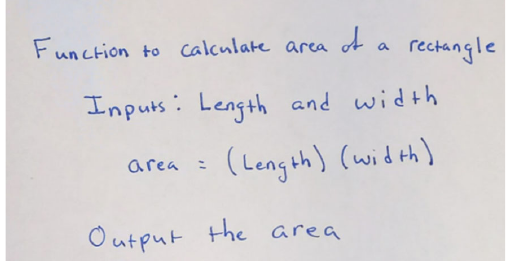
FIG. 3. An example of a pseudo-code for calculating the area of a rectangle. This function takes in two inputs — a length and a width. It multiplies the length by the width and stores that as the area, which the function